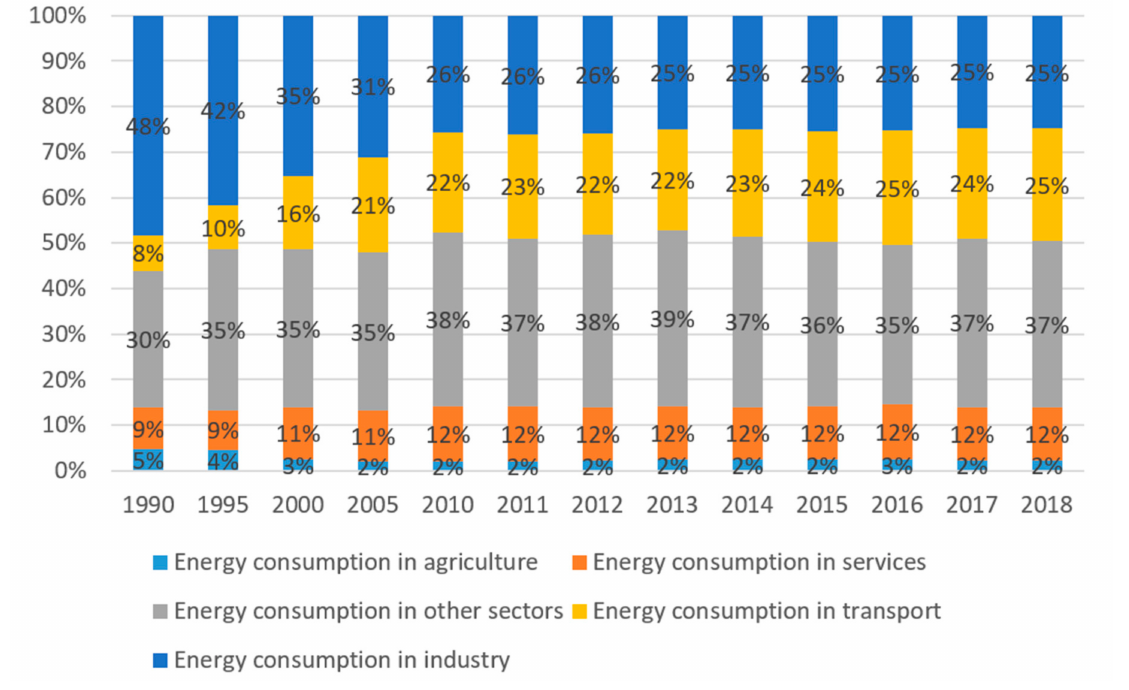
Figure 6. Structure of energy consumption in Czech Republic in 1990–2018. For Hungary, the structure of energy consumption was quite stable in the analysed period (Figure 7). The smallest consumption, the energy utilization in agriculture, de- creased by two percentage points (from 5.47% in 1990 to 3.19% in 2018). A stable situation was also recorded for services and other sectors. However, it should be noted that in 2000 the energy absorption was much higher when compared to other years (17.56%). A similar situation was also recorded for other sectors. Between 1995 and 2012, the share was around 45%. An upward trend can be observed (from 14.17% to 23.81%) for transport and a downward trend for industry in the first part of the analysed period. After 2013, the industry consumption was approximately 21%.